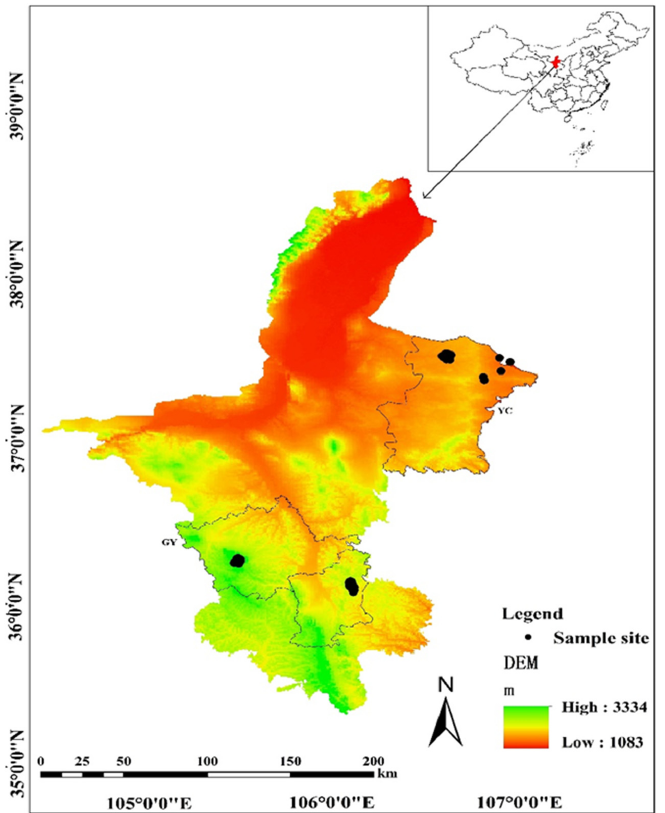
Figure 1. The location of sampling sites and region boundaries within Ningxia Province, northwestern China (YC, Yanchi region; GY, Guyuan region).